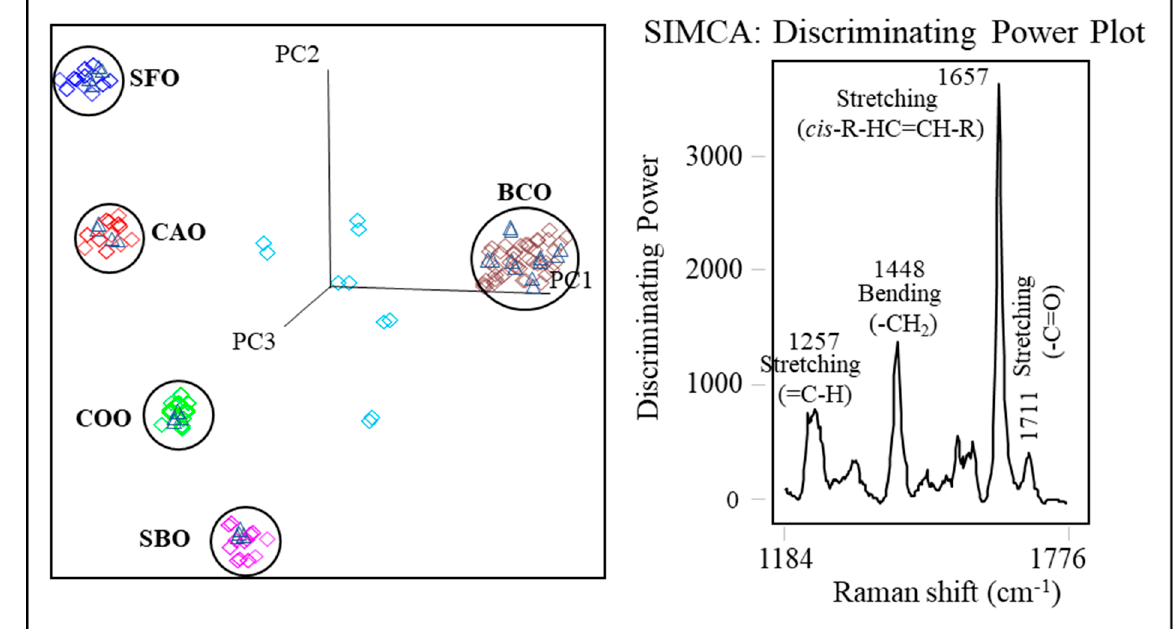
Figure 3. Soft independent modeling of class analogy—3D projection and discriminating power by SIMCA obtained from portable Raman. BCO: black cumin oil; CAO: canola oil; COO: corn oil; SBO: soybean oil; SFO: sunflower oil; triangles: validation; unclassified: adulterated black cumin oils; PC1-2-3: Principal Component.